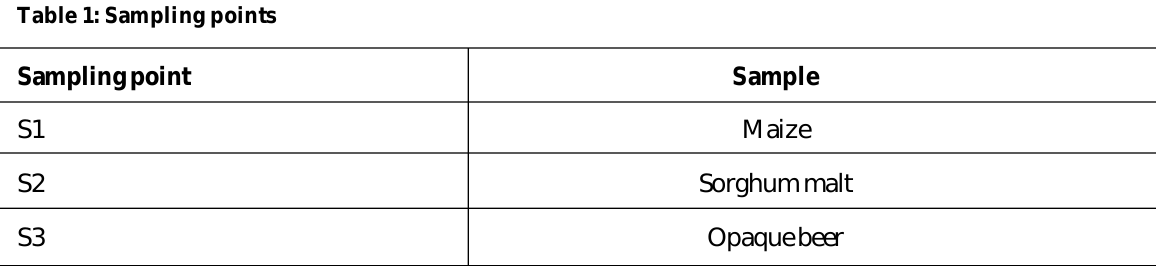
Table 1: Sampling points Sampling point